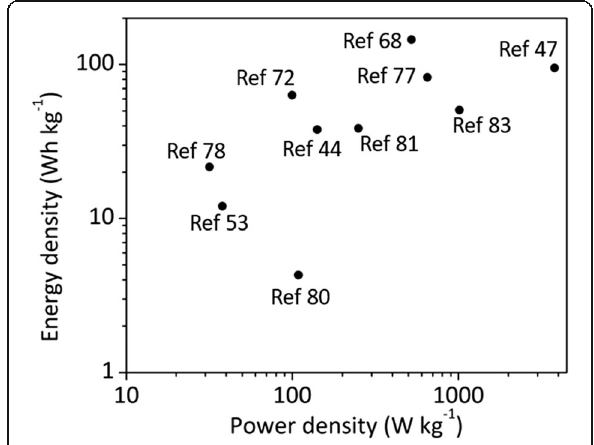
Fig. 10 Ragone plot of graphene and CP